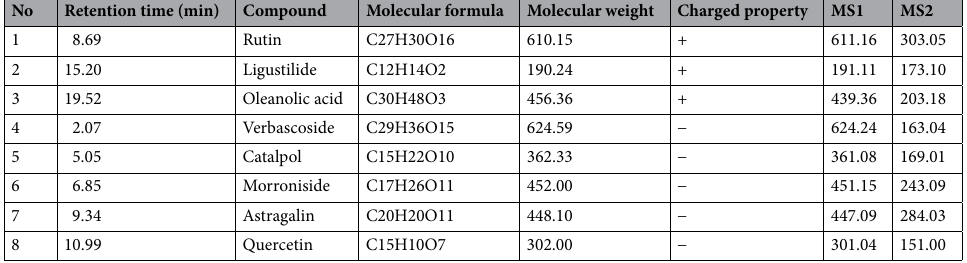
Table 3. Eight antioxidant components of ions identified in Bushen-Tiaojing-Fang. MS1 primary parent ion, MS2 second ions which are the characteristic fragments of MS1 after fragmentation by mass spectrometry.